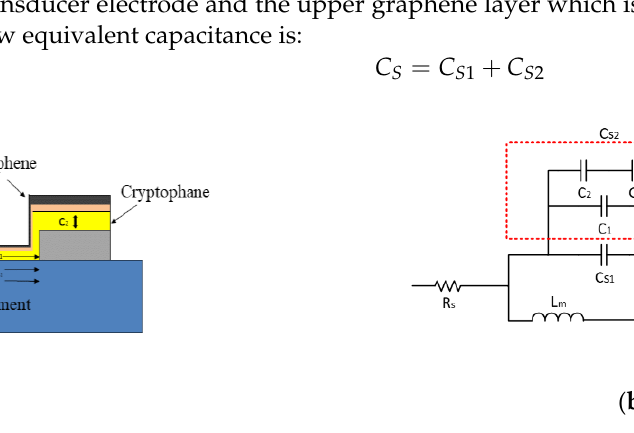
Figure 1. Equivalent circuit model: ( a ) Physical model; ( b ) Equivalent circuit.